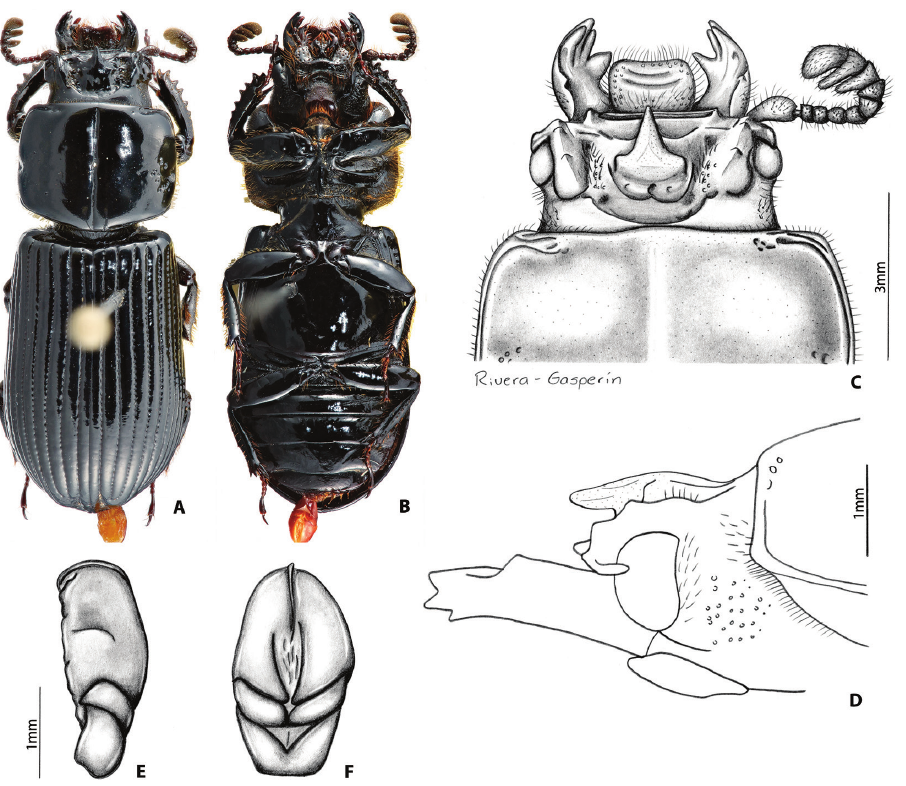
Figure 6. Yumtaax veracrucensis Beza-Beza, Reyes-Castillo & Jameson, sp. n. , holotype: A dorsal habitus B ventral habitus C dorsal view of pronotum and head D lateral view of pronotum and head E lateral view of aedeagus F ventral view of